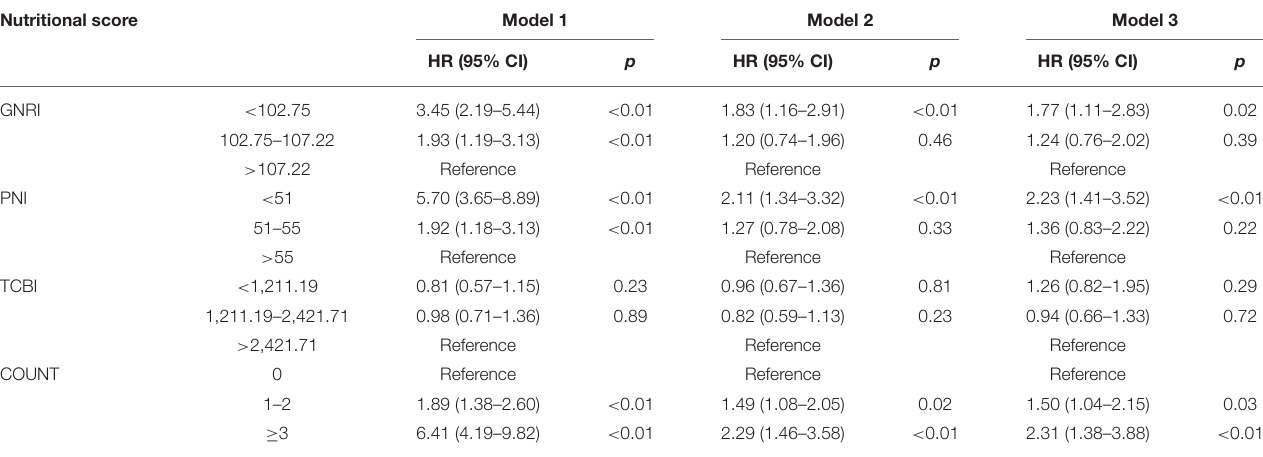
TABLE 3 | Cox regression analysis of nutritional scores with cardiovascular death. Nutritional score